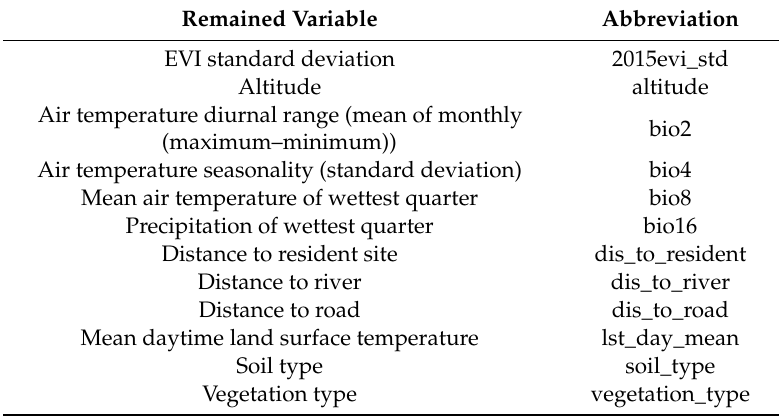
Table 2. Remaining variables selected by Pearson correlation and jackknife test for assembling the Maxent